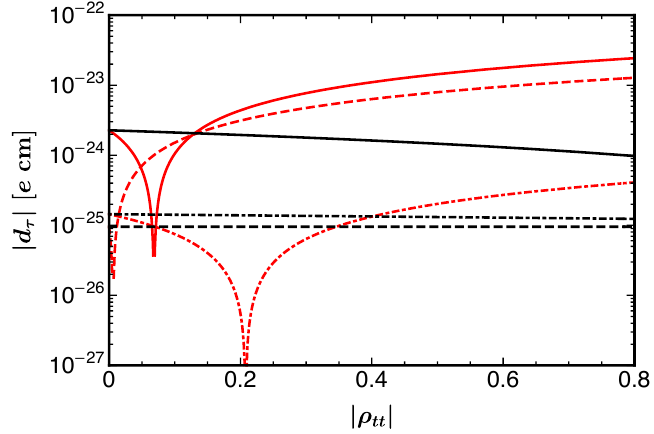
Figure 4 . Different two-loop contributions to | d τ | as function of ρ tt , taking ρ ττ = iλ τ . Color coding is the same as in figure